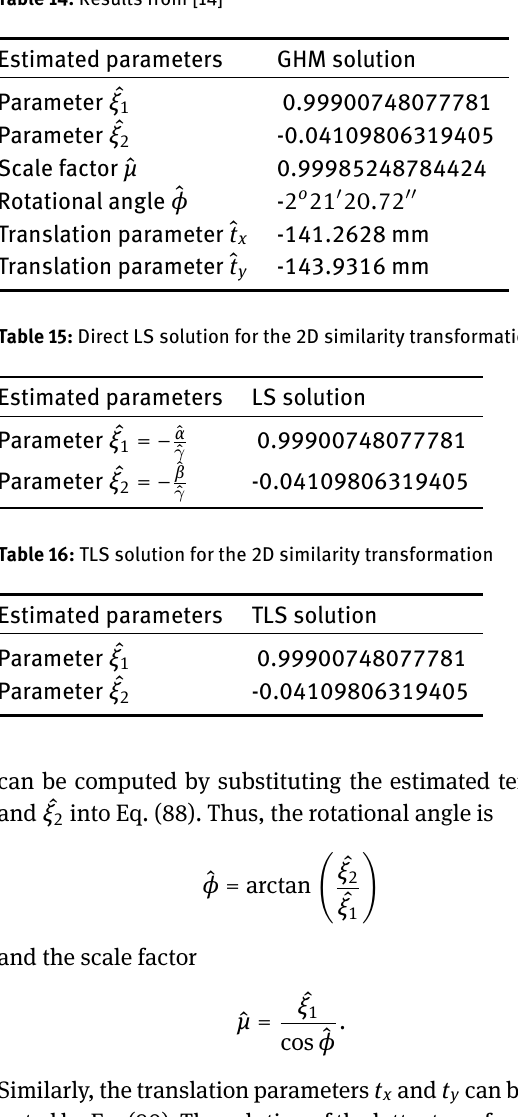
Table 14: Results from [14]